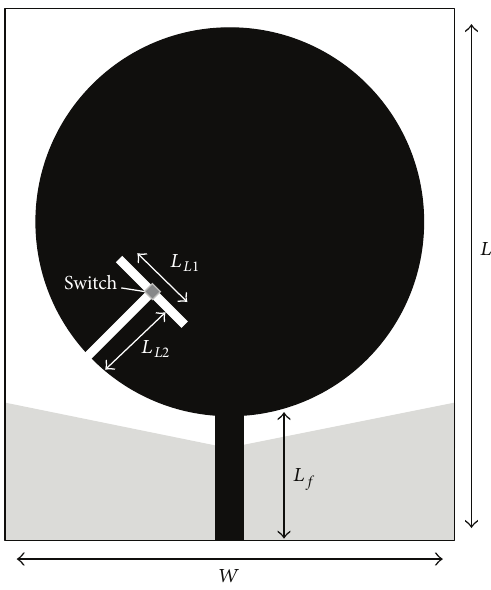
Figure 1: The design geometry of the proposed ultrawideband antenna.